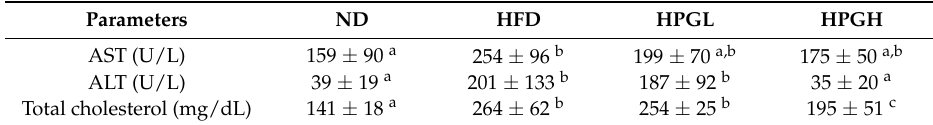
Table 2. Biochemical serum parameters of mice fed a Normal Diet (ND), a High-Fat Diet (HFD), HFD with 1% Platycodon grandiflorum (PG) extract (HPGL), and HFD with 5% PG extract (HPGH).